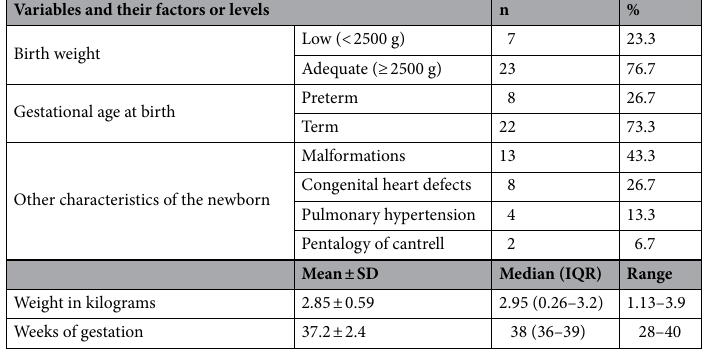
Variables and their factors or levels Condition of the omphalocele